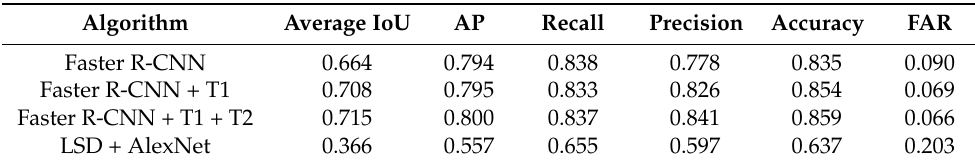
Table 1. Numerical performance. T1 denotes adding additional scale and aspect ratios, and T2 denotes sieving low quality positive samples. “Faster R-CNN+T1+T2” is the proposed method.